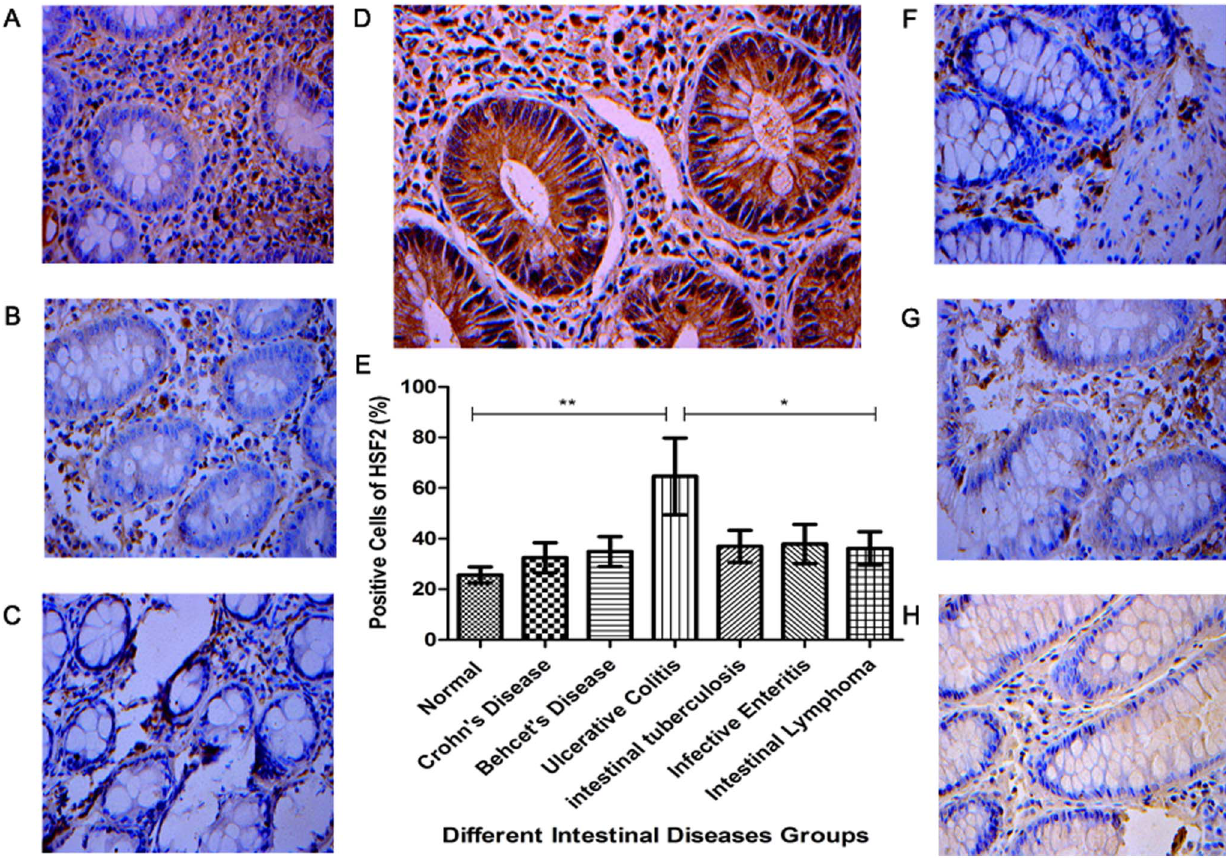
Figure 3. Expression of HSF2 in colonic mucosa tissues was examined by IHC. A : Representative normal colonic mucosa tissue was stained with anti-HSF2 antibody; B, C , D , F , G and H : Representative colonic mucosa tissues of Crohn’s disease, Behcet’s disease, ulcerative colitis, intestinal tuberculosis, infective enteritis, and intestinal lymphoma were stained with anti-HSF2 antibody, respectively (magnification, 6 400); E : Positive cell expression of HSF2 was compared. All IHC results were read automatic image analyzer, measured by HPIAS-2000 analytic software. *, p , 0.05;**, p , 0.01.